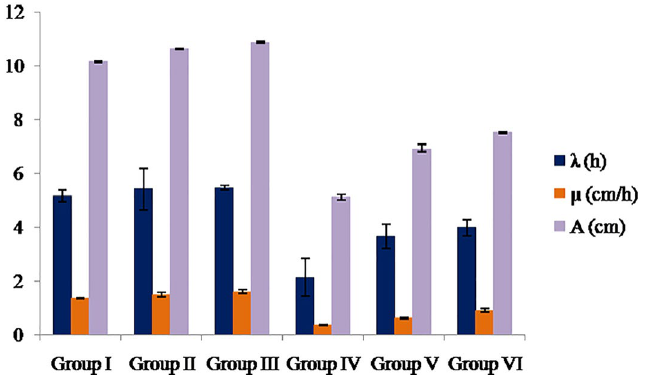
Figure 1. Effects of penoxsulam and blueberry treatments on root elongation kinetics. (Group I: tap water (control), Group II: 25 mg/L BBE, Group III: 50 mg/L BBE, Group IV: 20 μg/L penoxsulam, Group V: 20 μg/L penoxsulam + 25 mg/L BBE, Group VI: 20 μg/L penoxsulam + 50 mg/L BBE. Data are shown as mean ± standard deviation